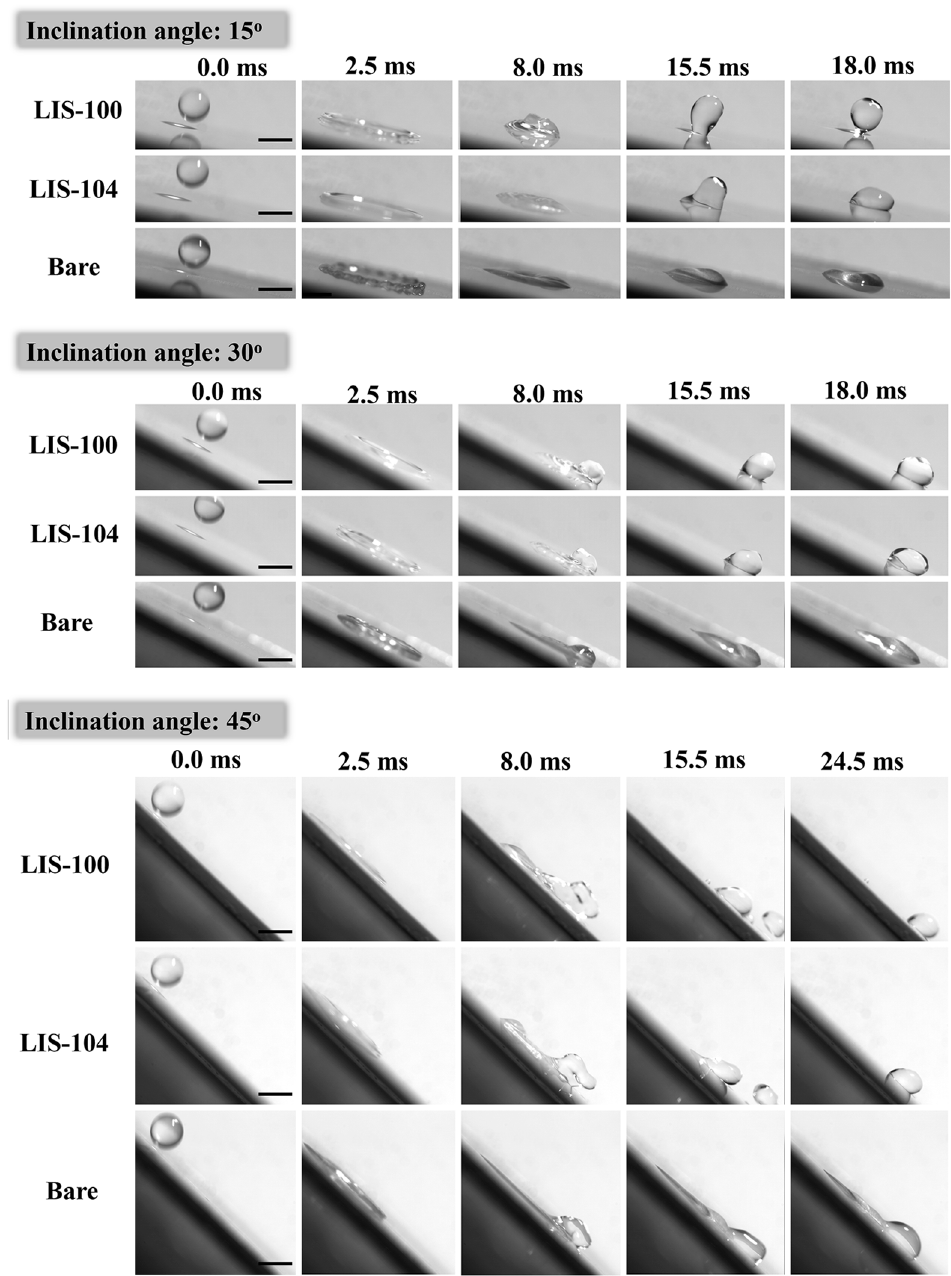
Figure 7. Time evolution of a water drop impacting sample surfaces at different inclination angles; the scale bar is 2 mm.